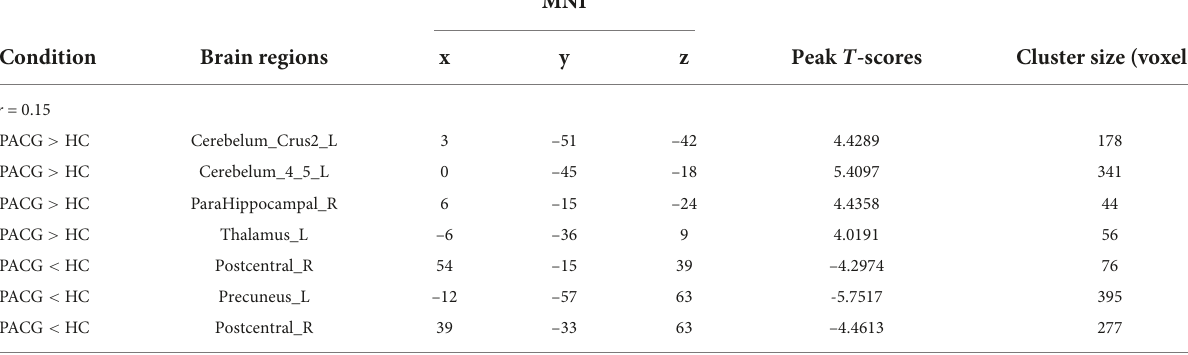
TABLE 2 Significant differences in the DC between the two groups ( r = 0.15).